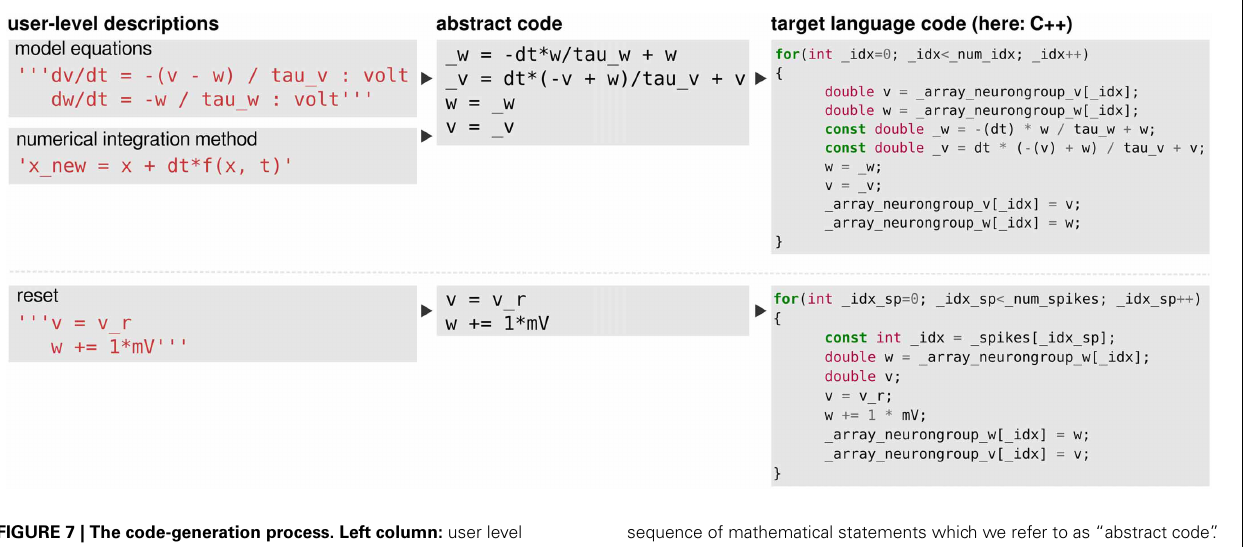
sequence of mathematical statements which we refer to as “abstract code”. This involves no change in the case that the user provided a sequence of statements. Right column: the sequence of abstract code statements is converted into valid code in the target